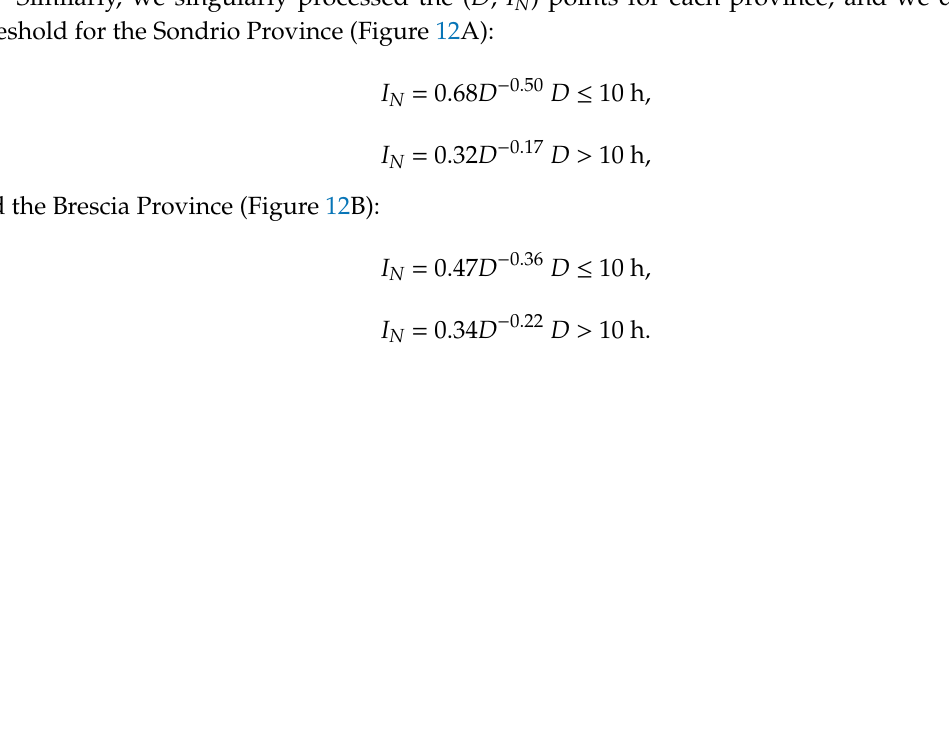
Figure 12. Rainfall events (coloured marks) that have resulted in soil slips and mud-debris flows in the Sondrio ( A ) and Brescia ( B ) Provinces in the period 1927–2008. Coloured lines represent the 10% thresholds for different duration ranges (blue and violet, D < 10 h; sky-blue and lilac, D > 10 h).